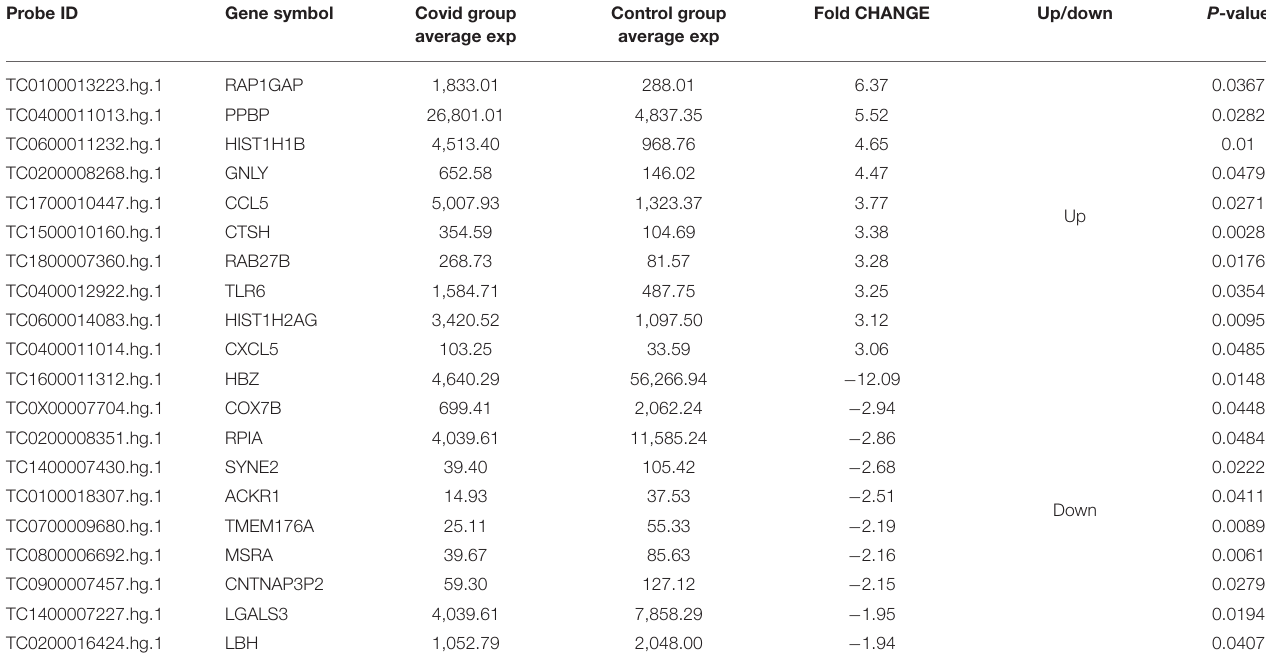
TABLE 2 | Top 10 differentially up- or down-regulated genes associated with exposure to Covid. Probe ID Gene symbol Covid group